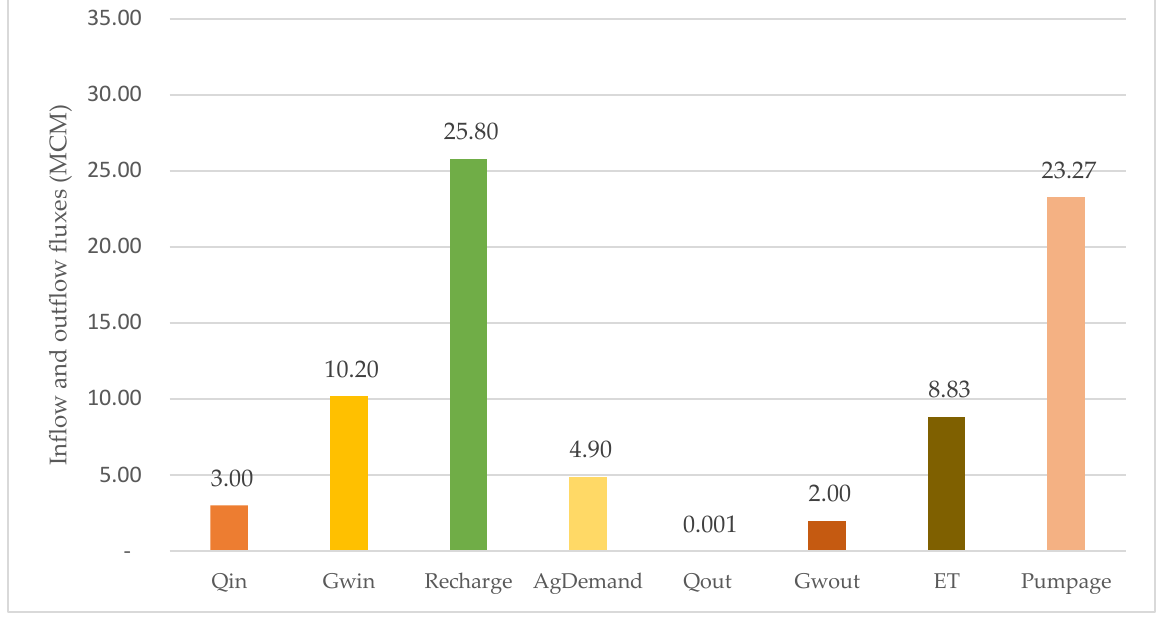
Figure 4. The 1954–2020 average inflow and outflow fluxes for maintaining sustainable conditions.